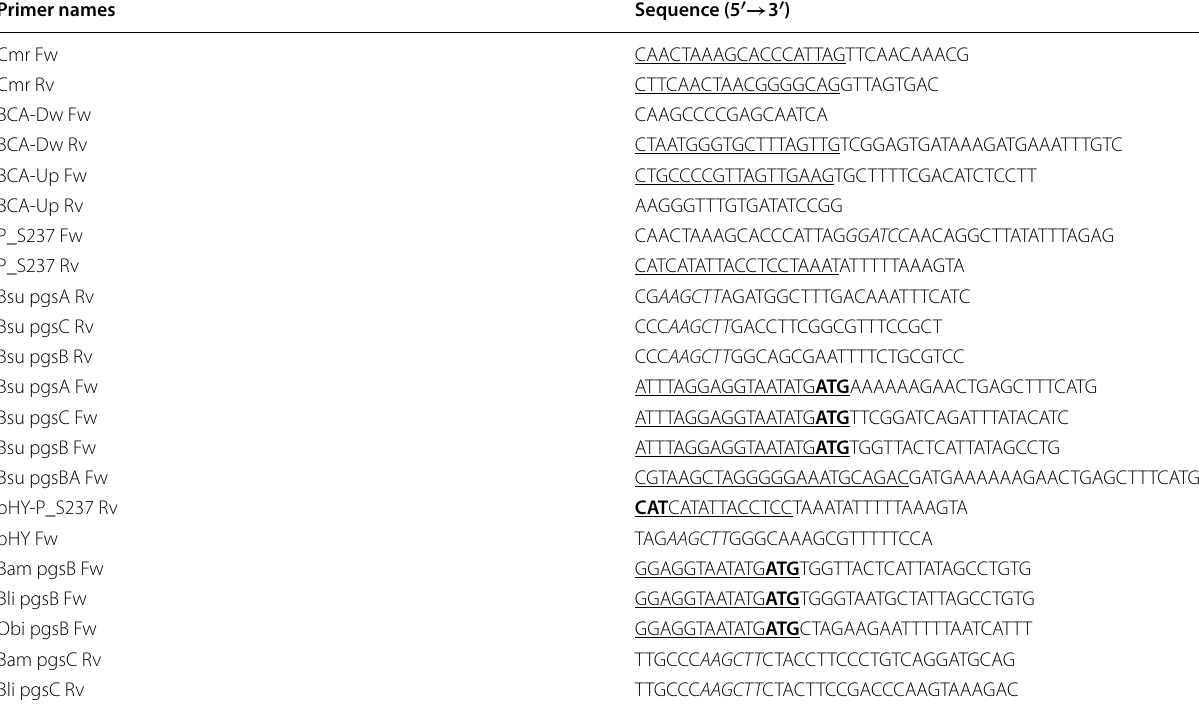
Italic sequences represent synthesized restriction enzyme sites; underlined sequences represent homologous regions for spliced overlapping extension (SOE)-PCR; bold sequences represent initiation codons for the open reading frames (ORFs) of each gene